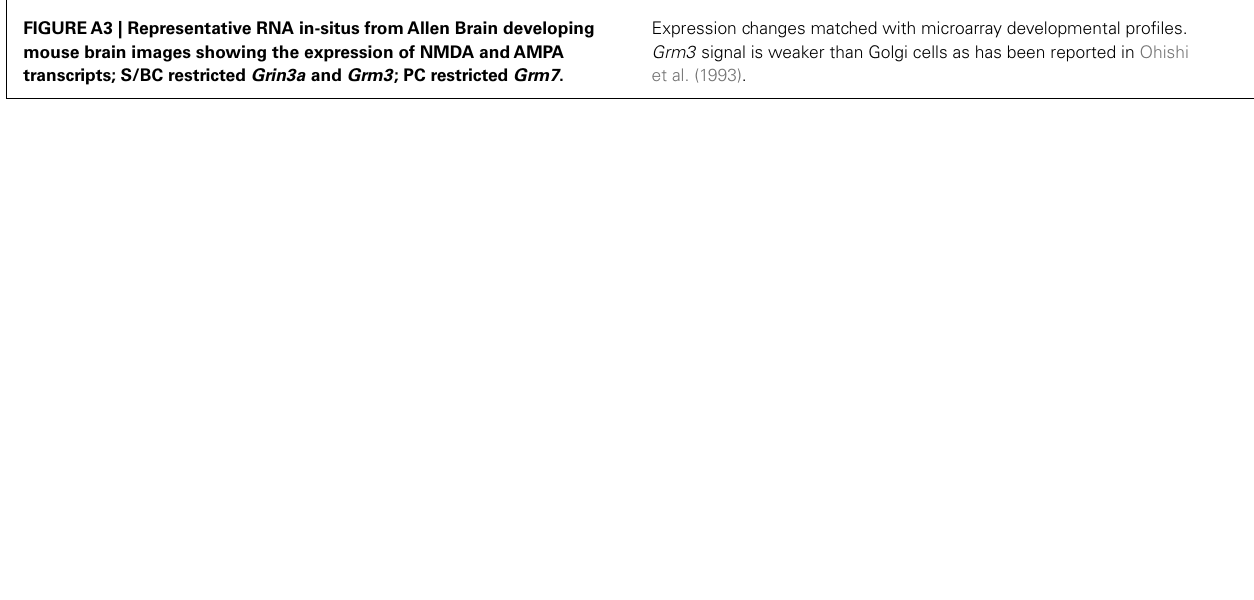
FIGUREA3 | Representative RNA in-situs fromAllen Brain developing mouse brain images showing the expression of NMDA andAMPA transcripts; S/BC restricted Grin3a and Grm3 ; PC restricted Grm7 .